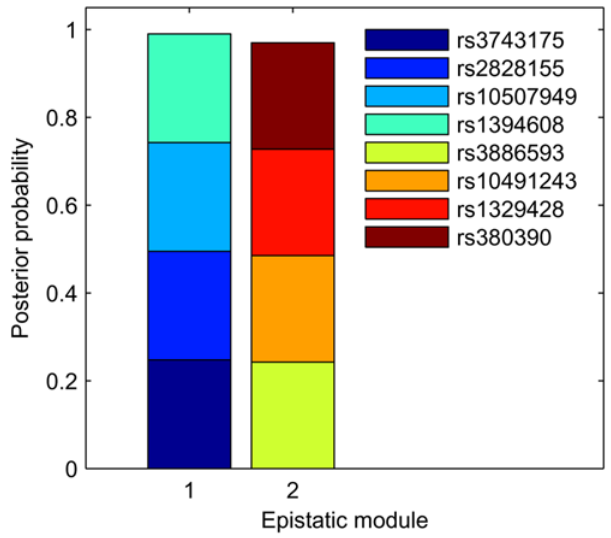
Figure 6. Posterior probabilities of epistatic modules identified in the AMD data set. The prior probability that a marker is involved in a module is set to 10/103611. The cutoff posterior probability for reporting an epistatic module is